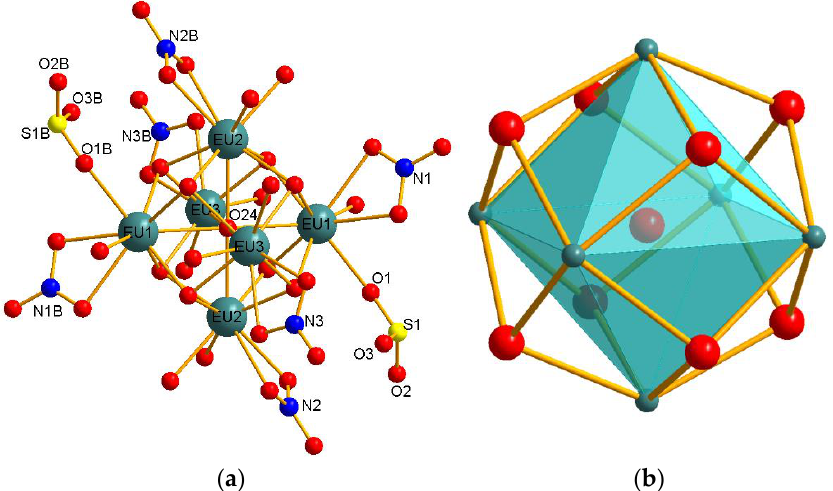
Figure 1. ( a ) Coordination environment of the Eu(III) ions in compound 1 ; ( b ) hexanuclear Eu(III)-O clusters in compound 1 . Symmetry codes: (A) − x + 2, − y+4, − z + 2; (B) − x + 3, − y + 4, − z + 1 (the C atoms and H atoms were omitted for clarity).